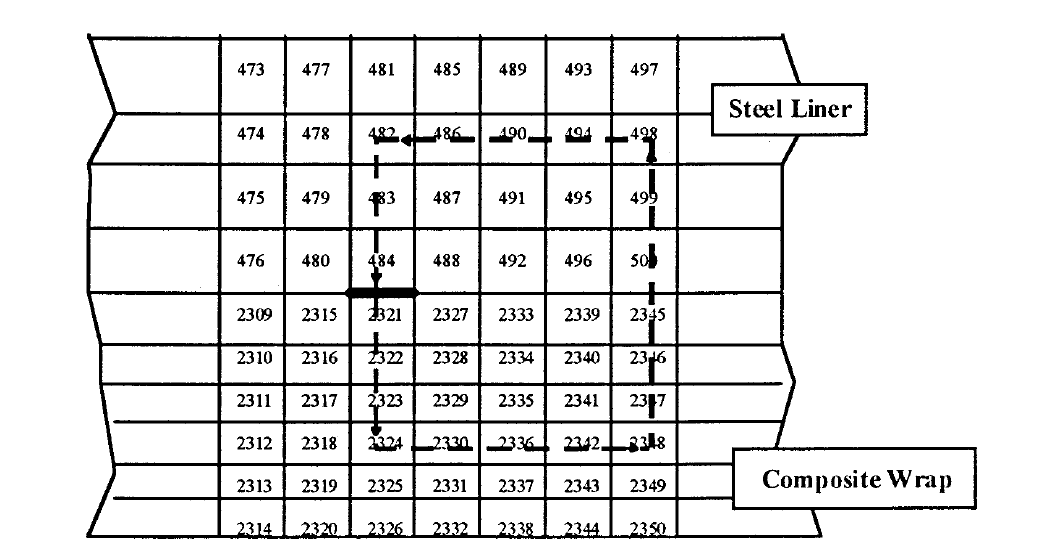
Fig. 5. Radial displacement at the inner radius of composite wrap.